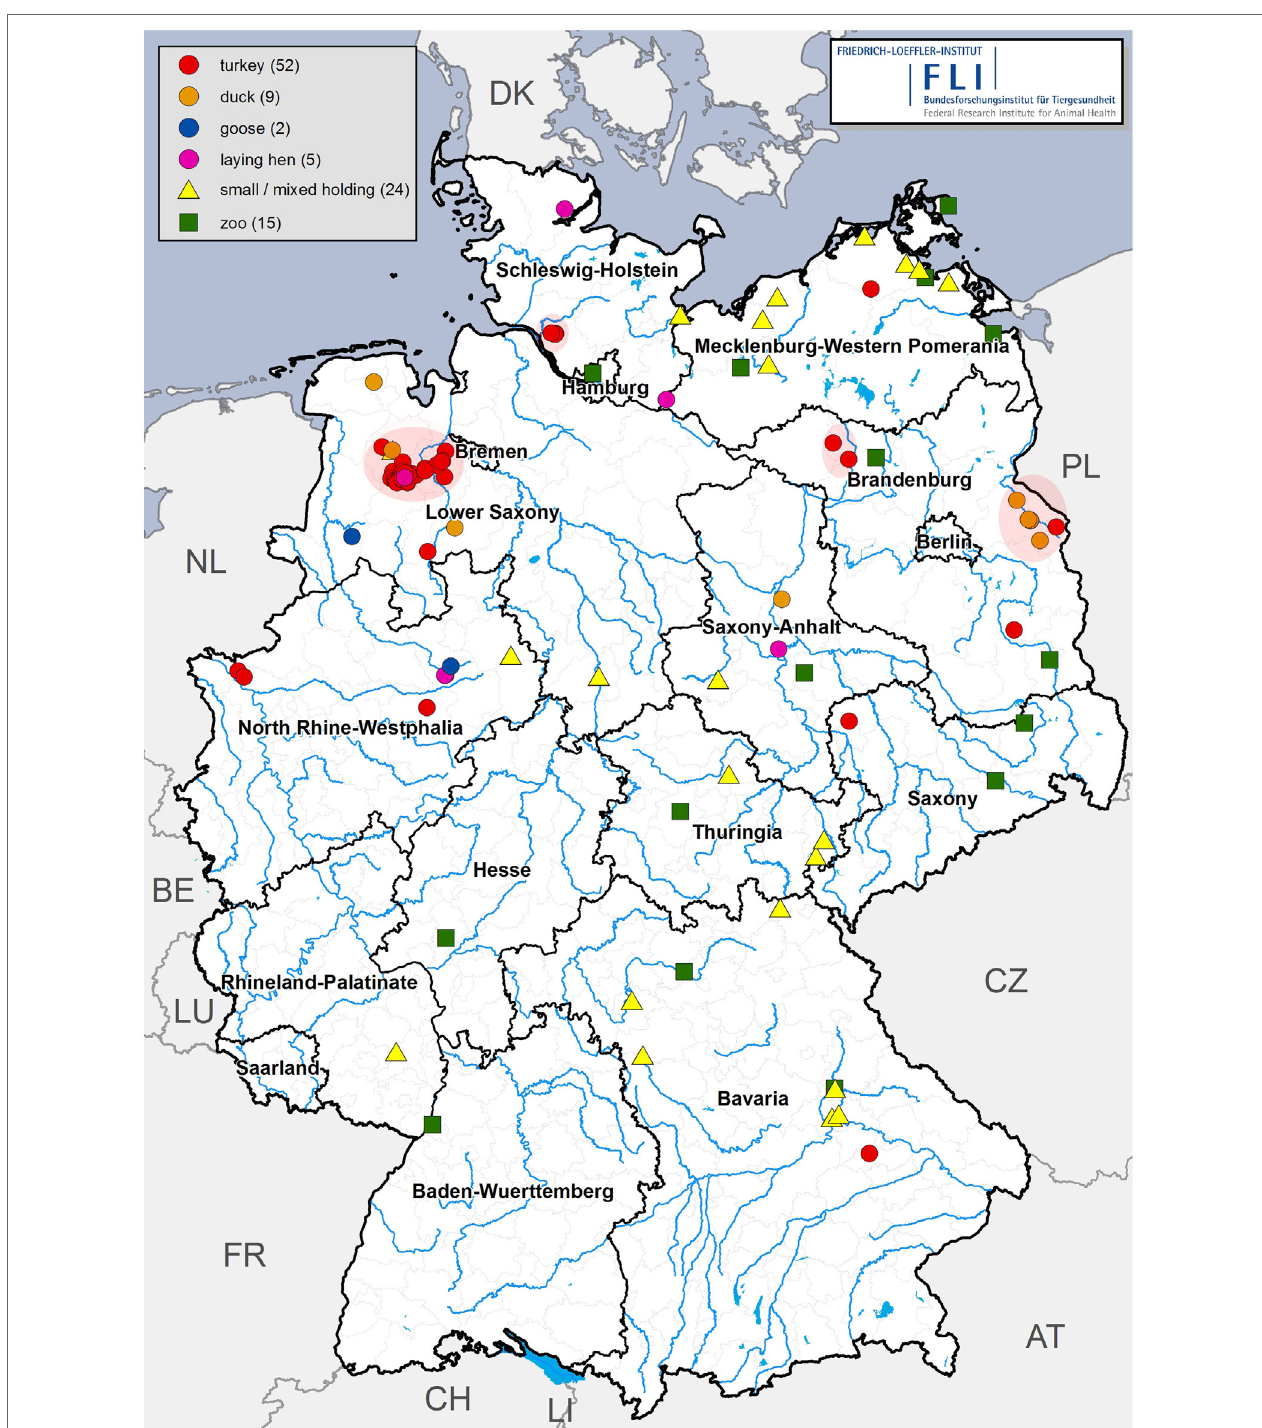
FigUre 3 | Highly pathogenic avian influenza in holdings of captive birds in Germany since November 2016. Red points: turkeys (52), orange points: ducks (9), blue points: geese (2), pink points: laying hens (5), yellow triangles: small scale, mixed holdings (24), and green squares: zoos (15). Red circles indicate outbreaks where farm-to-farm spread most likely